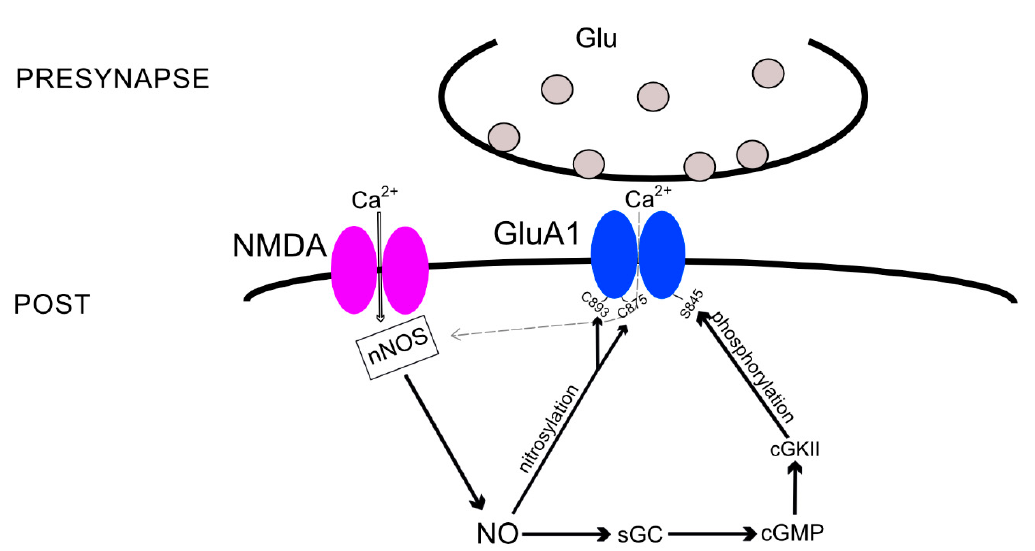
Figure 1. Schematic presentation of indirect cyclic guanosine monophosphate (cGMP)-dependent pathway and direct nitrosylation of glutamate ionotropic receptor AMPA type subunit 1 (GluA1) regulating its incorporation into the synaptic membrane. Calcium influx through N -methyl- d -aspartate (NMDA) or calcium-permeable AMPA (CP-AMPA) receptors activates the neuronal NO-synthase (nNOS) to produce nitric oxide (NO), which can either directly nitrosylate GluA1’s C893 [78] or C875 [80], causing the subunit’s insertion into the membrane or phosphorylates the GluA1’s S845 via the soluble guanylate cyclase (sGC)-cGMP-cGMP-dependent protein kinase II (cGKII) pathway activation [69–71].